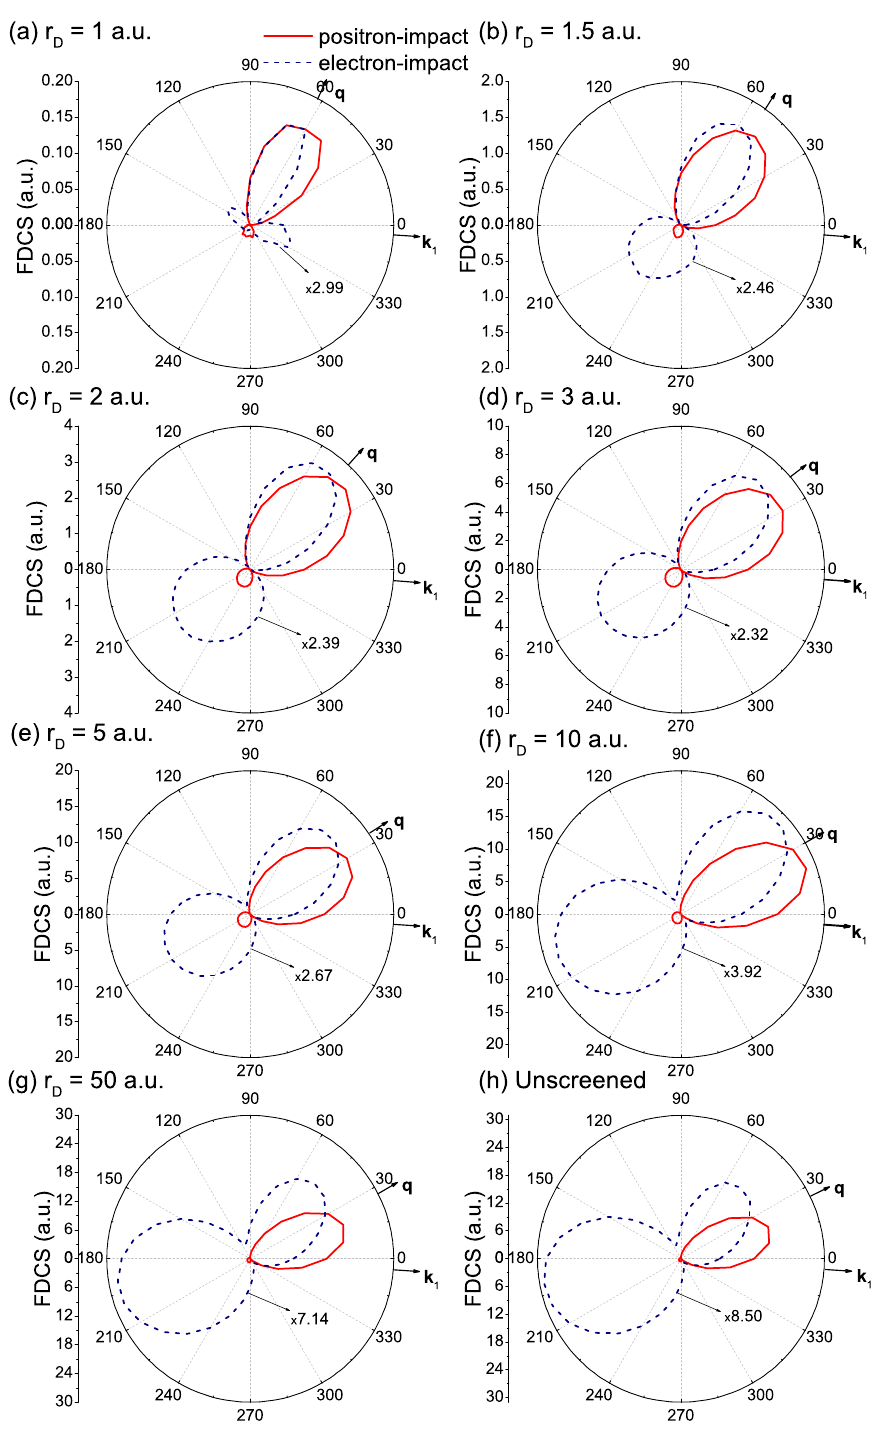
Figure 4. The Born-3DW fully differential cross section in the scattering plane for positron (solid line) and electron (dashed line) impact as a function of the emitted electron angle. The emitted electron energy is 5 eV, and the projectile scattering angle is θ 1 = − 4 ◦ ( k 1 indicated in the polar plots). Cross sections are shown for different r D -values. The unscreened asymptotic limit is also